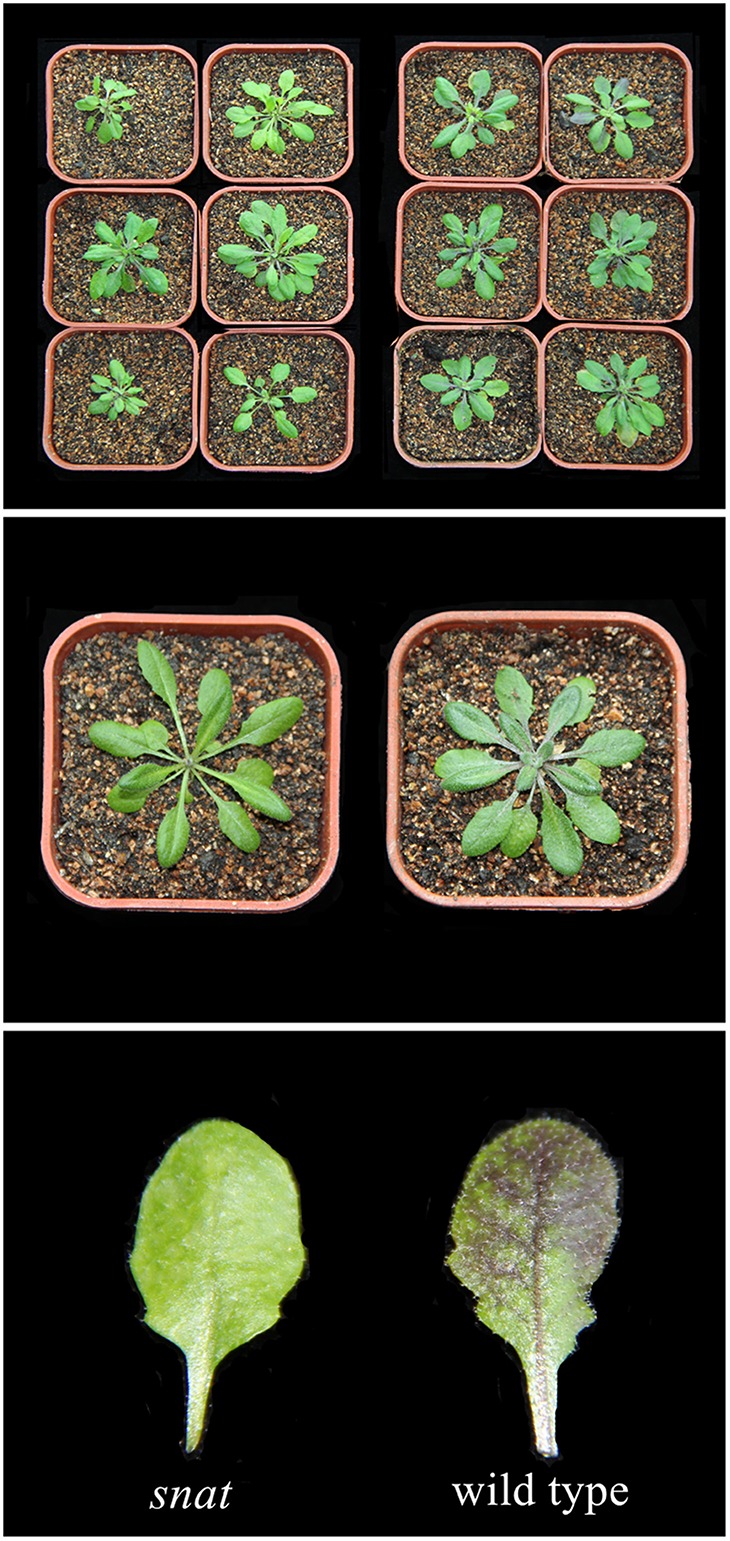
Anthocyanin accumulation in wild type Arabidopsis and melatonin defect mutant.